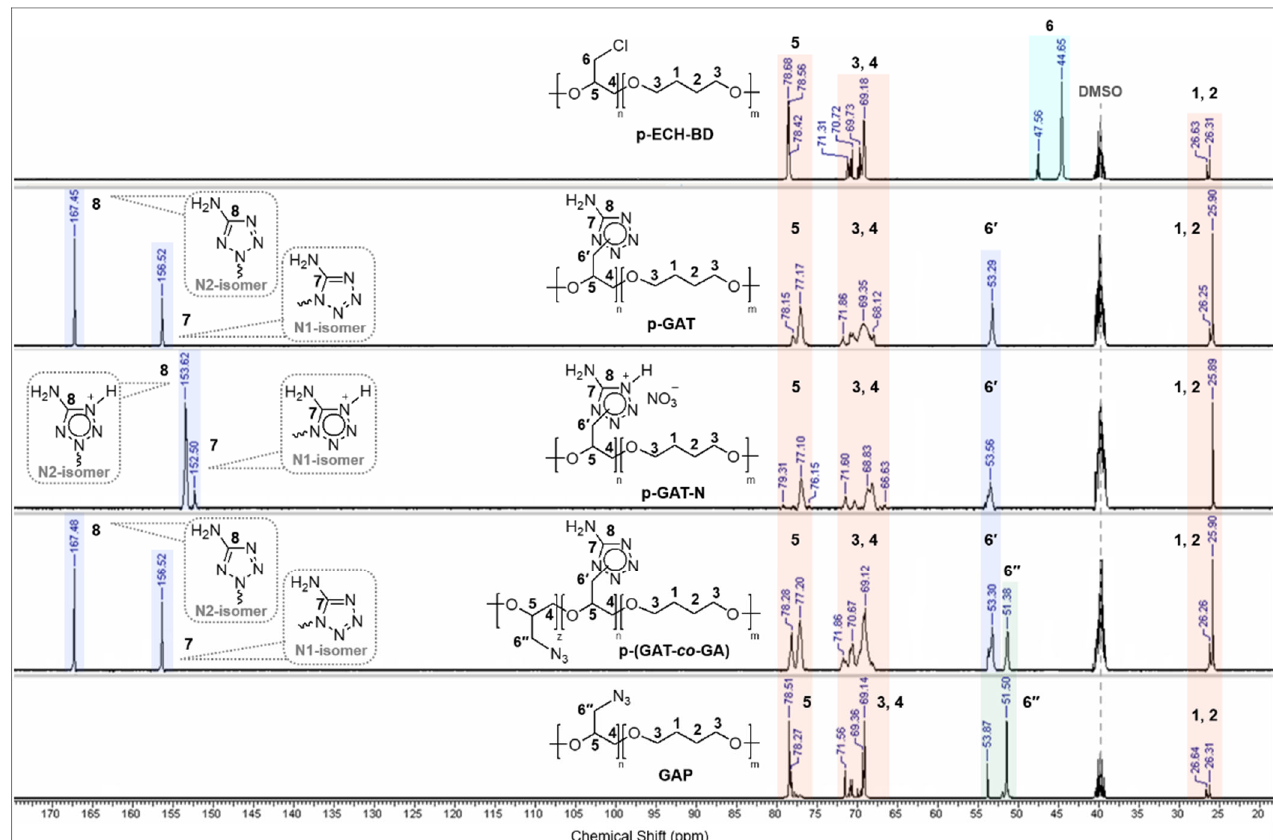
Figure 2. 13 C NMR spectra of p ‐ ECH ‐ BD, p ‐ GAT, p ‐ GAT ‐ N, p ‐ (GAT ‐ co ‐ GA) and GAP polymers.